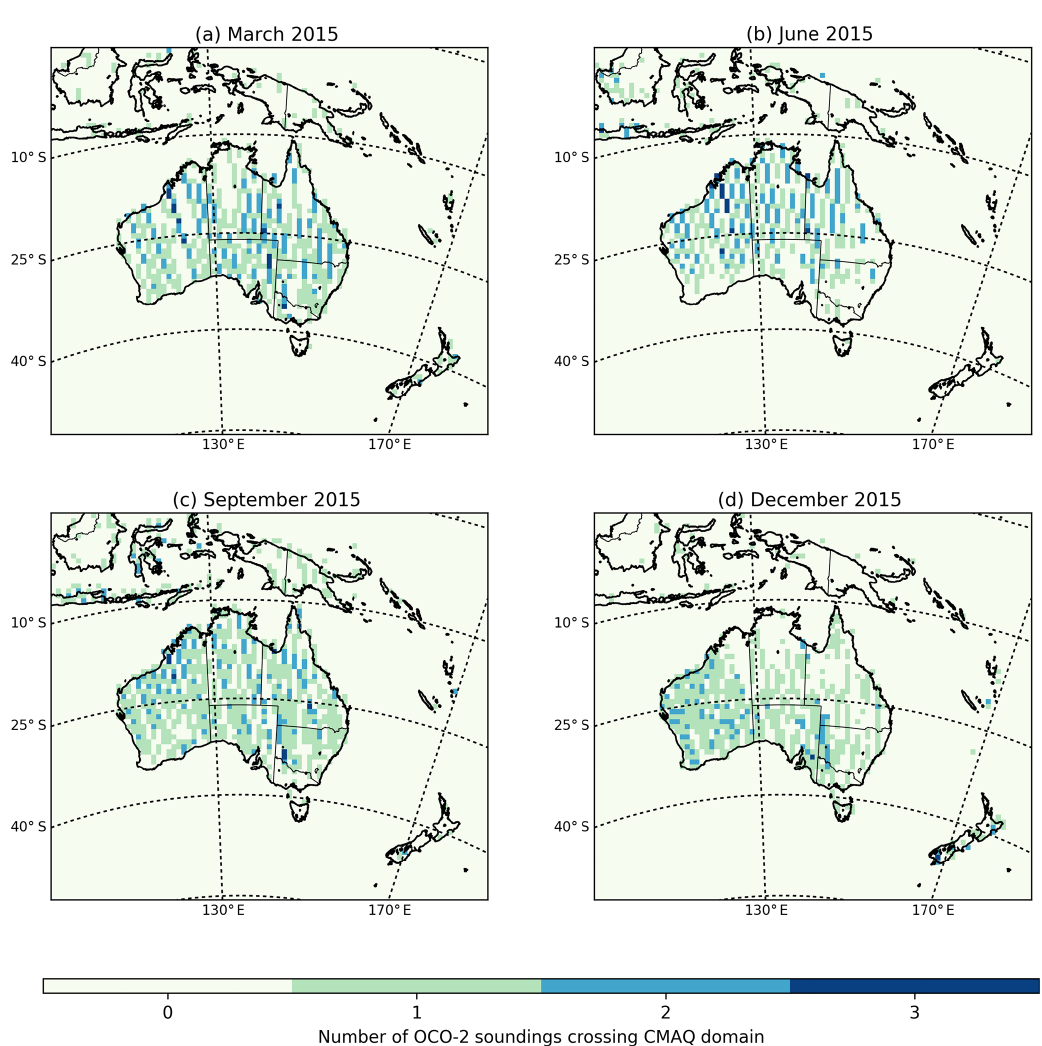
Figure 2. Spatial distribution of OCO-2 soundings (land nadir and glint data) over the CMAQ domain for March, June, September and December